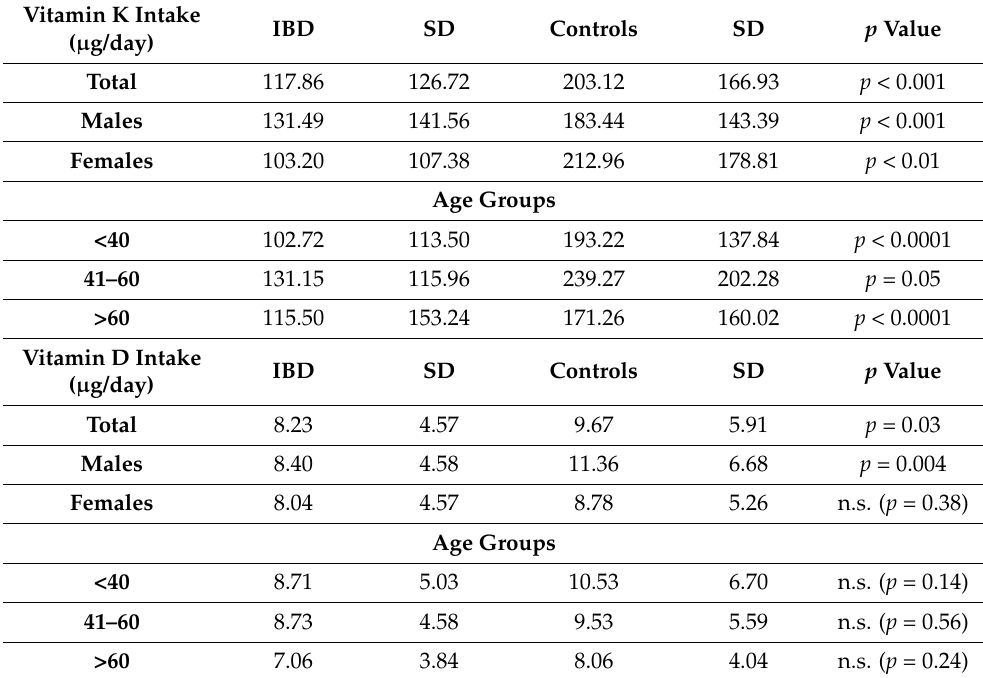
Table 2. Vitamin K and D intake in IBD and controls in relation to gender and age.